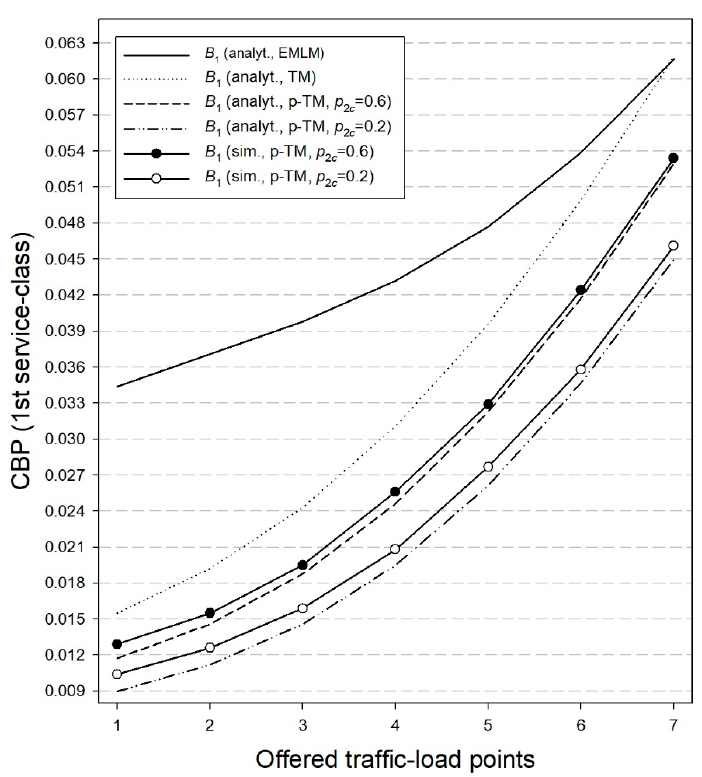
Figure 5. CBP—First service-class (probabilistic threshold loss model).